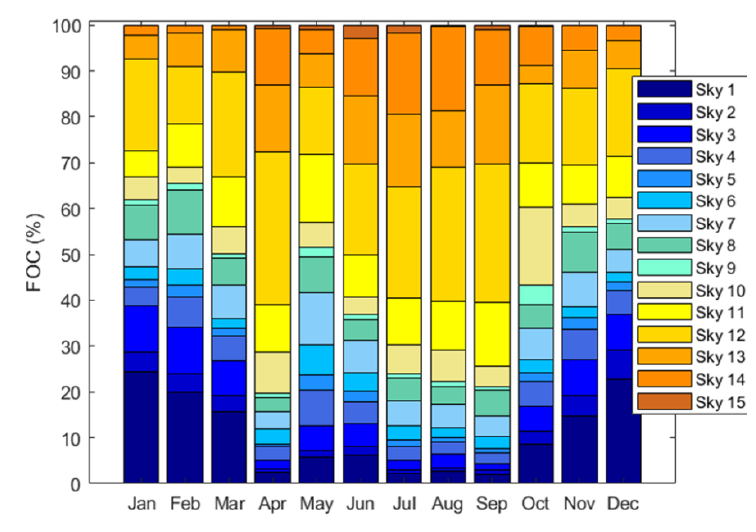
Figure 8. Monthly FOC of the CIE standard sky type in Burgos, Spain, between September 2016 and January 2019.